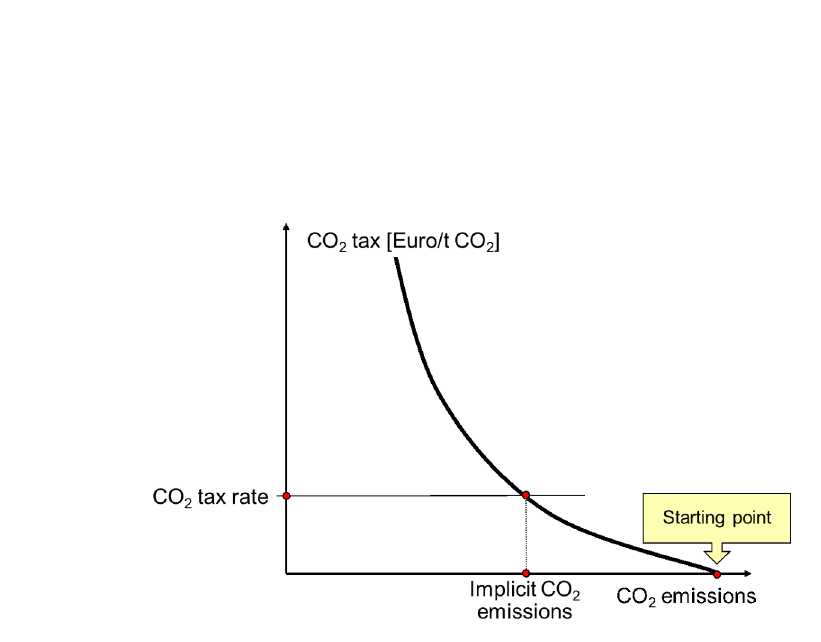
Fig. 2. – CO 2 abatement cost and a CO 2 tax